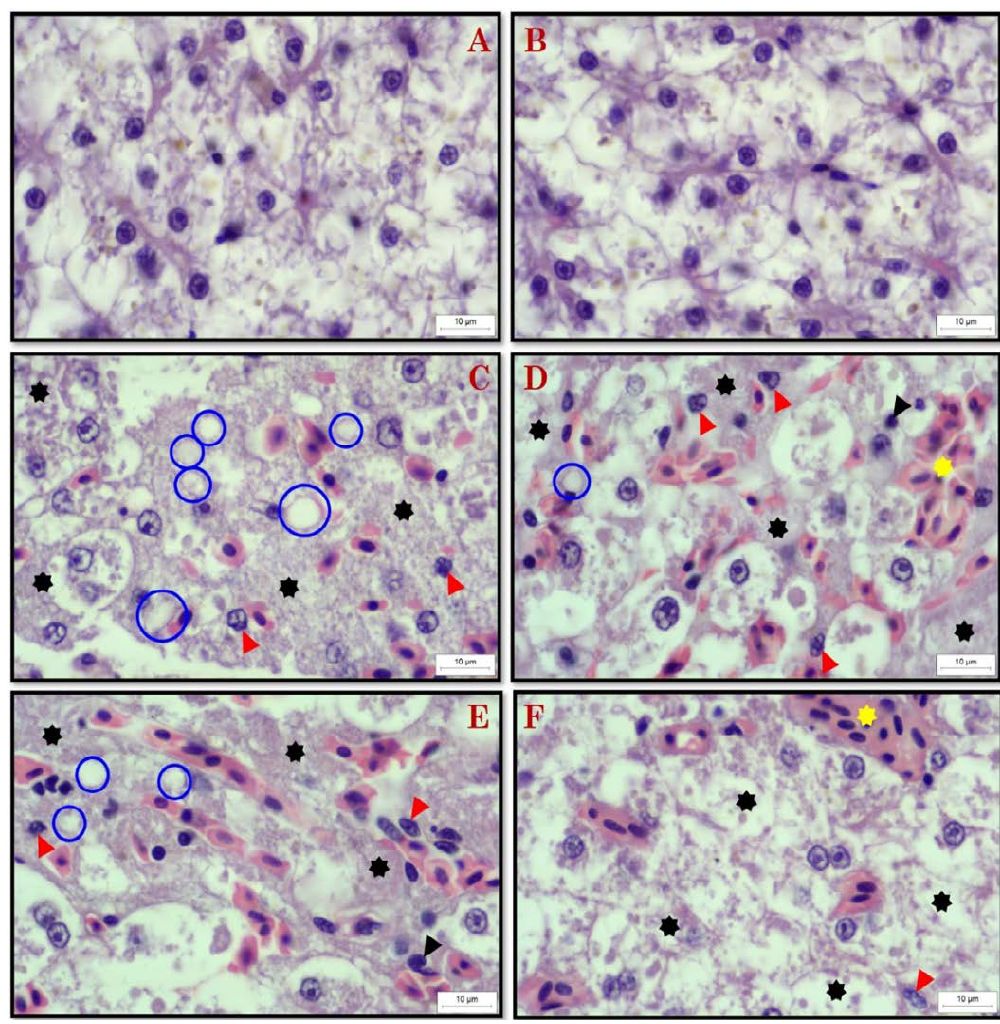
Fig. 4: Disturbances in the liver parenchyma of Aequidens metae exposed to PAH during 72 h. A) Non-injected control and B) solvent control show normal tissue with non-concentric nuclei and nucleoli and granular cytoplasm, C) exposed to β-naphthoflavone, D) exposed to naphthalene, E) exposed to phenanthrene and F) exposed to benzo[a]pyrene. Note in the different microphotographs the hyperemia (yellow star), degeneration of the nuclei (red triangle), pyknotic nuclei (black triangle), degeneration of the cytoplasm (black star), vacuolization (blue circle). H and E staining, magnification x 400.